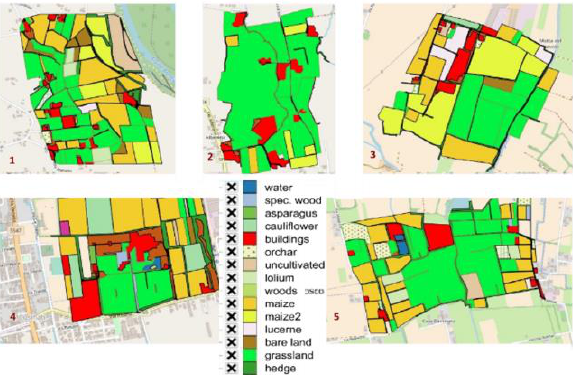
Figure 2. Land-use maps of the five sites: 1 Piciacio, 2 Albereria, 3 Palmirona, 4 Rossano, 5 Dussin